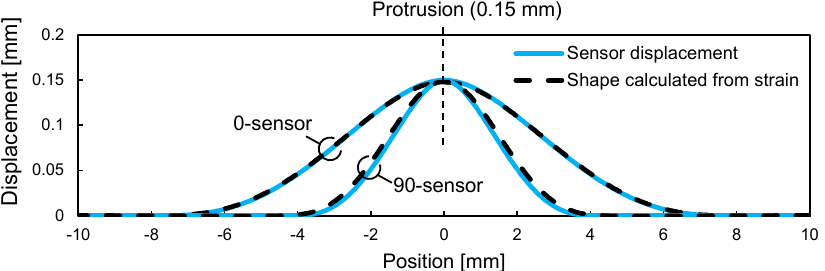
Figure 6. Comparison between sensor displacement and shape calculated from strain distribution along optical fibers.